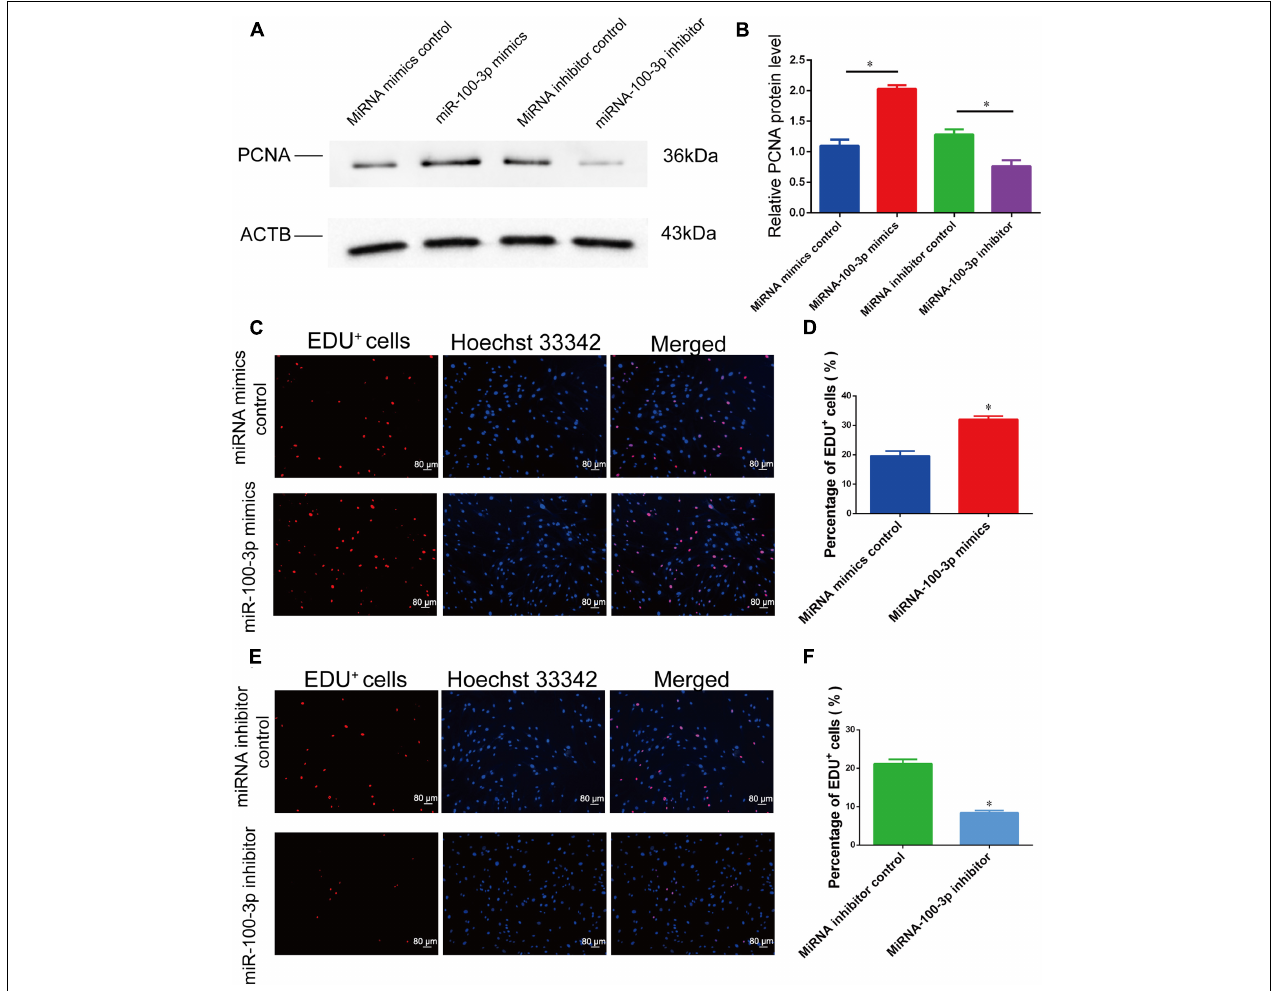
FIGURE 3 | MiR-100-3p affects human Sertoli cell DNA synthesis. (A) Proliferating cell nuclear antigen (PCNA) expression was shown by Western blots in human Sertoli cells at 72 h after miR-100-3p mimics or inhibitor transfection. (B) The relative expression of PCNA in human Sertoli cells at 72 h after miR-100-3p mimics and inhibitor transfection. (C–F) The ratios of 5-ethynyl-2 (cid:48) -deoxyuridine (EdU)-positive cells were illustrated by EdU incorporation assays in human Sertoli cell treatment with miRNA mimics control vs. the miR-100-3p mimics (C,D) as well as miR-100-3p inhibitor vs. miRNA inhibitor (E,F) . Scale bar in panels (C,E) = 80 µ m. * indicated the statistical difference between miR-100-3p mimics and miRNA mimics control or miR-100-3p inhibitor and miRNA inhibitor